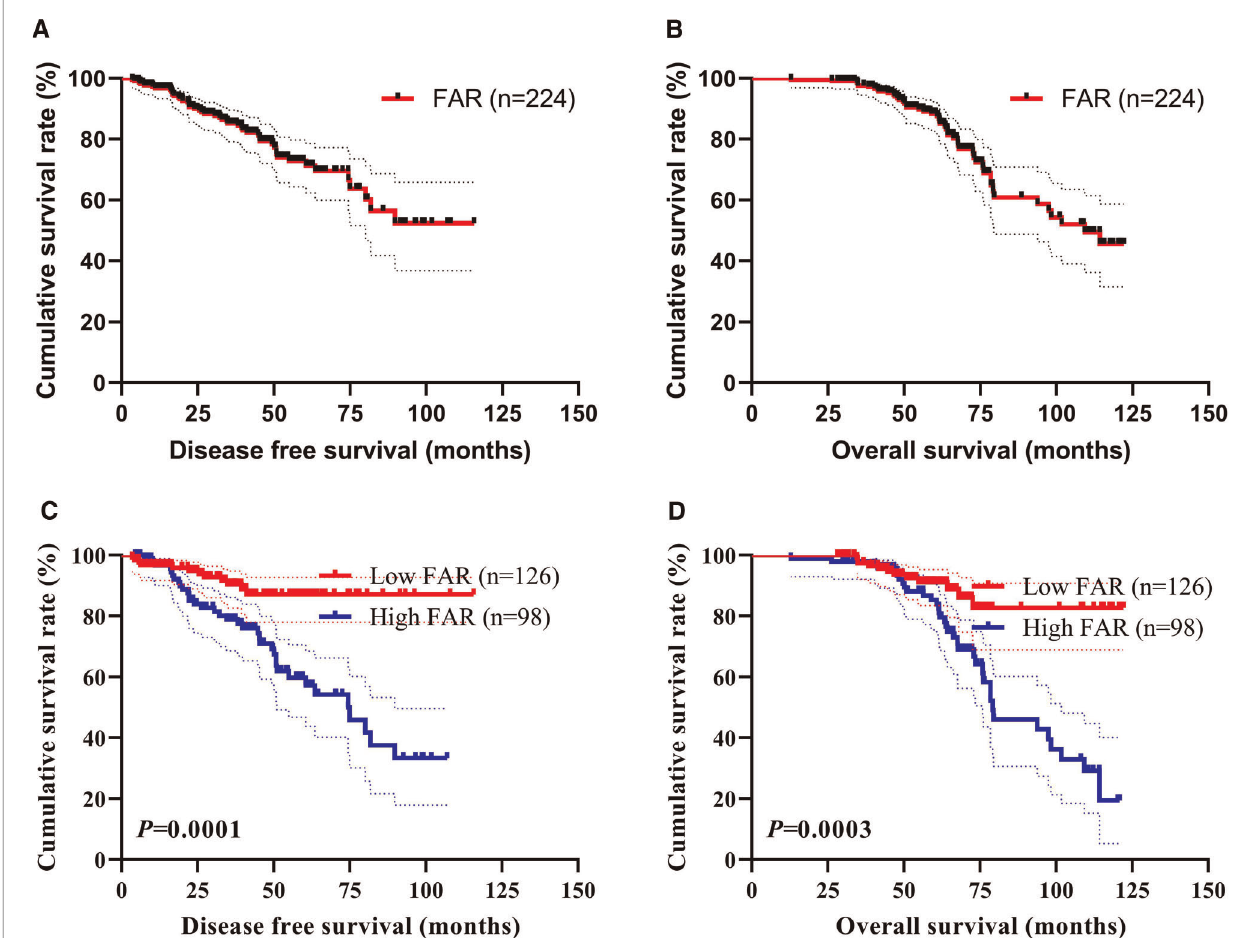
FIGURE 2 | Disease free survival (DFS) and overall survival (OS) in triple-negative breast cancer (TNBC). ( A ) All enrolled patients for DFS, ( B ) All enrolled patients for OS, ( C ) Correlation of FAR with DFS, ( D ) Correlation of FAR with OS. Statistical analyses were performed using log-rank